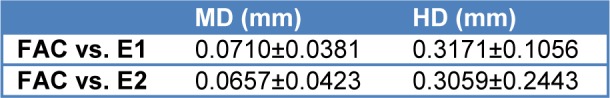
Calculation of Hausdorff and average distance between the manual and proposed method in area of abnormal thermal edge related to test run twice